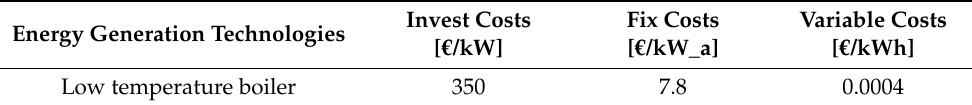
Table A1. Costs of the generation technologies